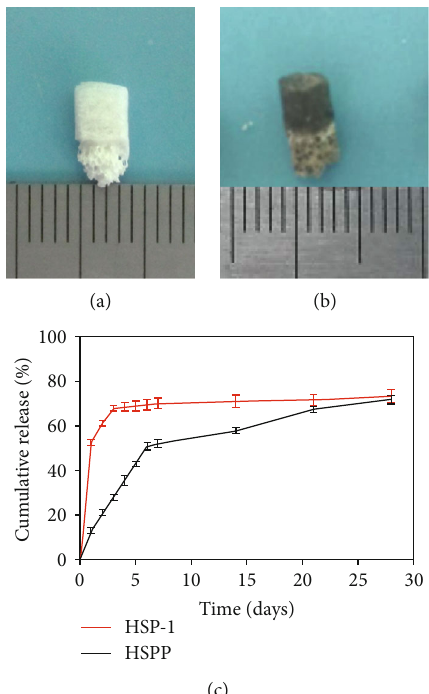
Figure 3: The appearance of sca ff old treated (a) without and (b) with polydopamine and (c) in vitro release pro fi les of PDGF from HSP-1 and HSPP sca ff